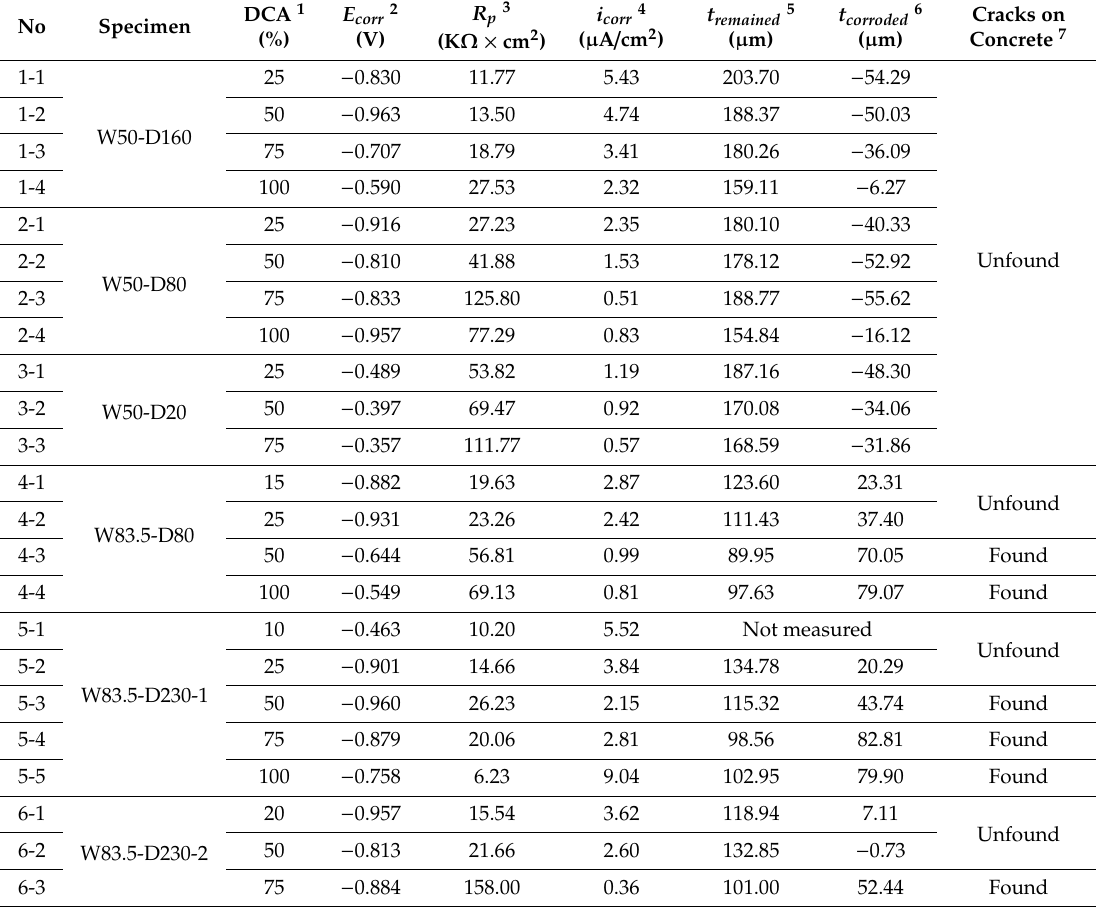
Table 4. Electrochemical properties and amount of corrosion of specimens, after the acceleration